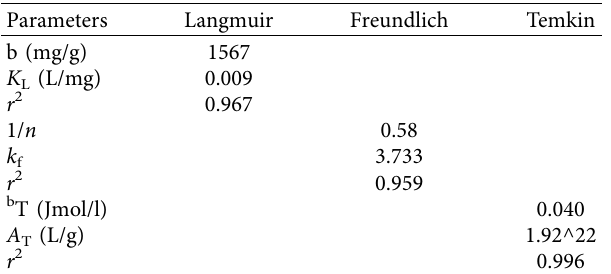
Figure 2: The adsorption isotherms of fluoride to the soil following the FSW amendment. Table 3: Isotherm parameters for the adsorption of fluoride in the soil succeeding fermented seaweed (FSW) amendment at 1.25% amendment dosage (62.5 mg